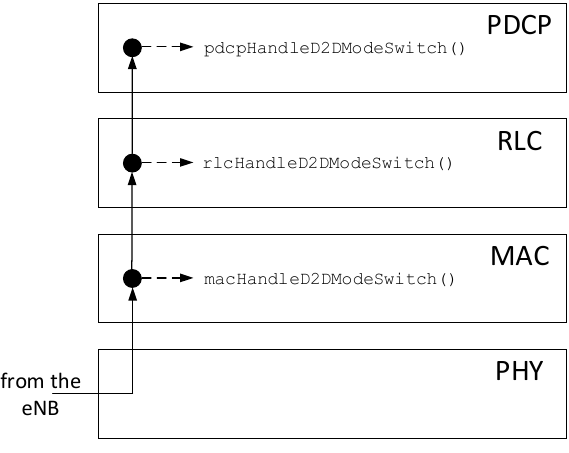
Figure 12. Management of the mode switching.